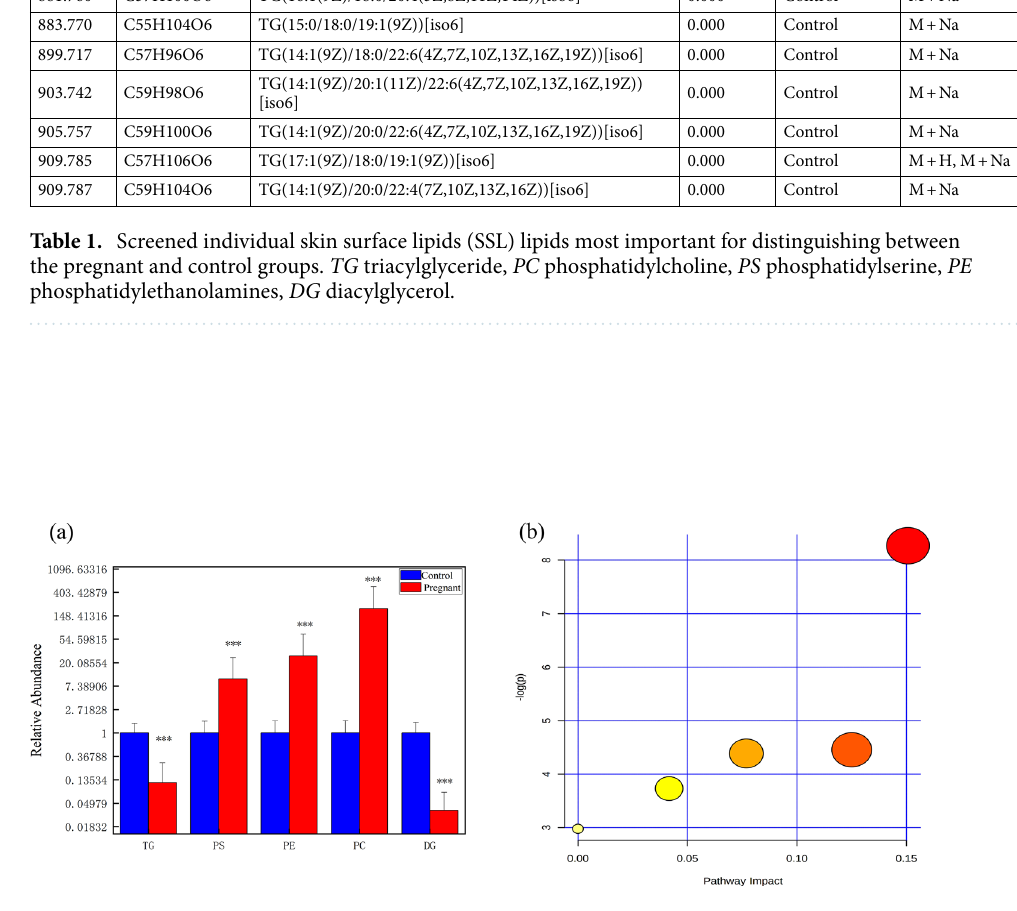
Figure 3. ( a ) Relative levels of important individual lipids in responsible for differentiating between the pregnant and control groups. TG, triglyceride. PS, phosphatidylserine. PE, phosphatidylethanolamines. PC, phosphatidylcholine. DG, diacylglycerol. ( b ) Metabolic pathway maps of important individual lipids responsible for differentiating between the pregnant and control groups. From left to right, the metabolic pathways in order are glycosylphosphatidylinositol (GPI)-anchor biosynthesis, linoleic acid metabolism, alpha-Linolenic acid metabolism, arachidonic acid metabolism, and glycerophospholipid had the largest impact factor and largest circle in the upper right corner, so it was considered the most important metabolic pathway. This pathway included the metabolic pathways involved in PC and PE.